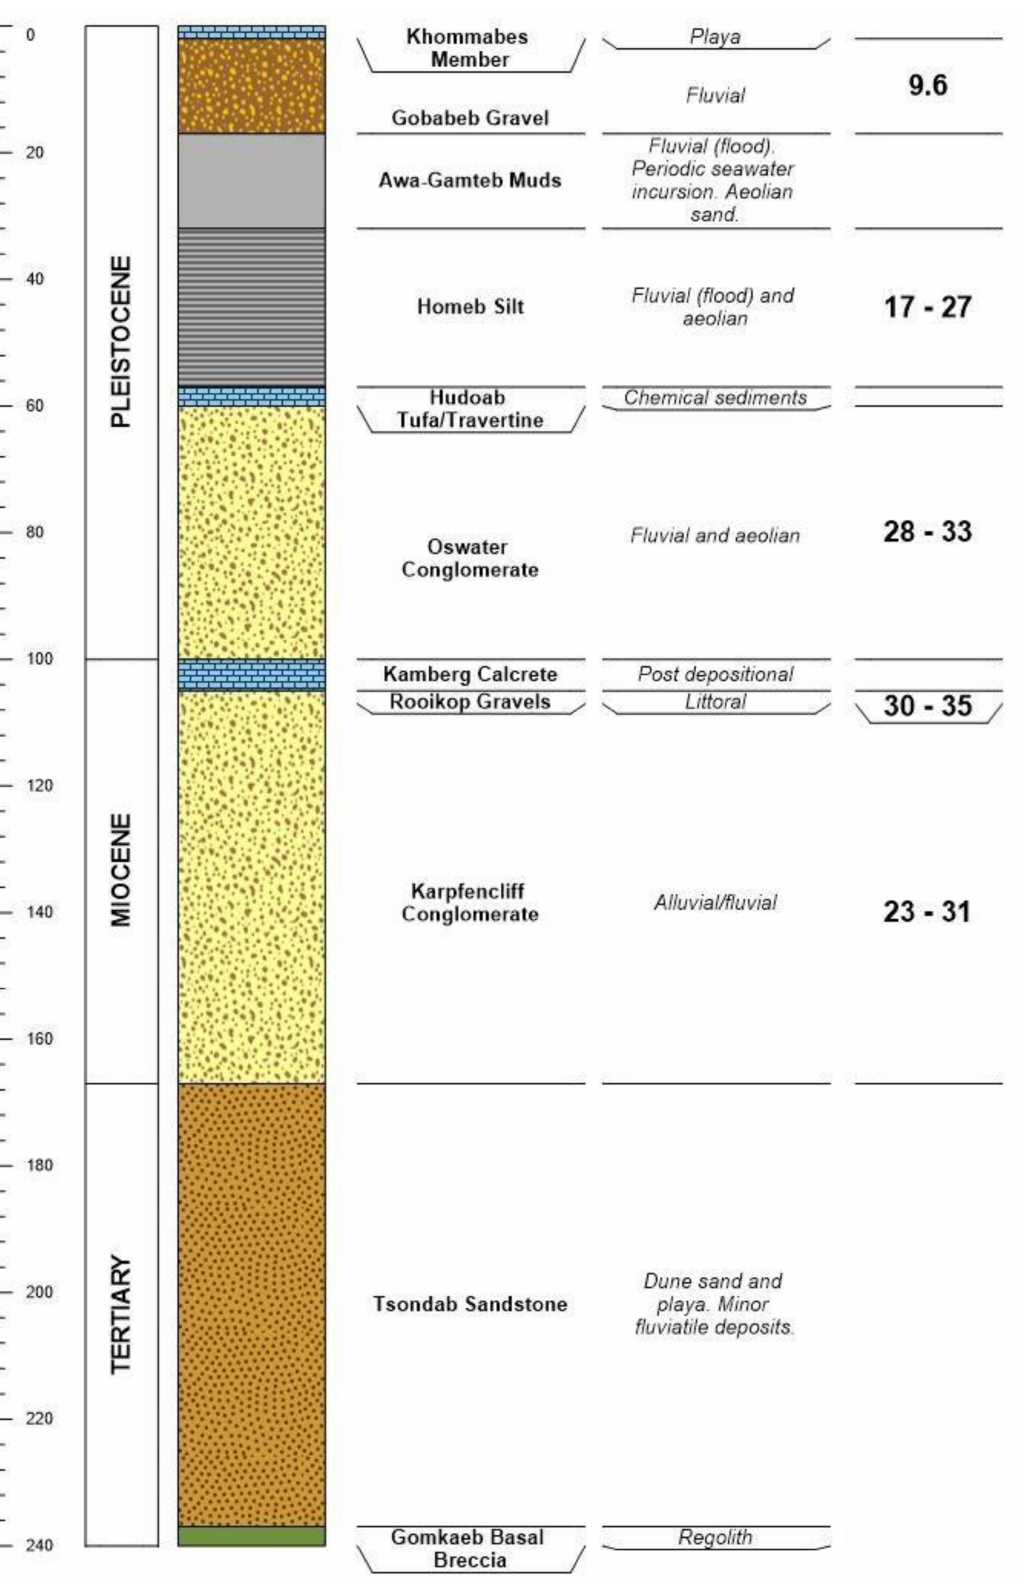
Figure 2. Stratigraphy of the Kuiseb Valley based on outcrop locations, as shown in Figure 1. Mainly after [14]. Figures to right are 14 C age ranges in Ka. Sources in